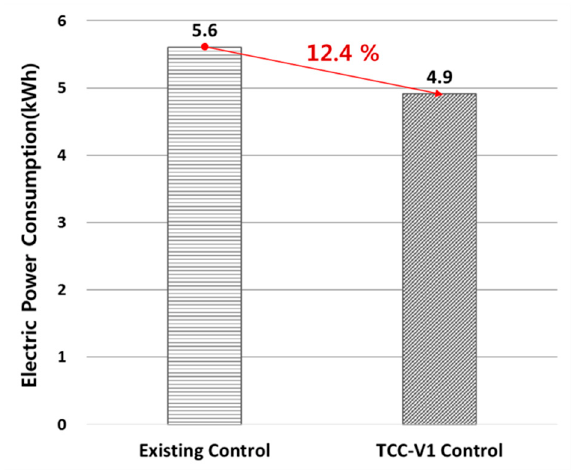
Figure 22. Comparison of electric energy consumption without and with TCC-V1 on October 17.